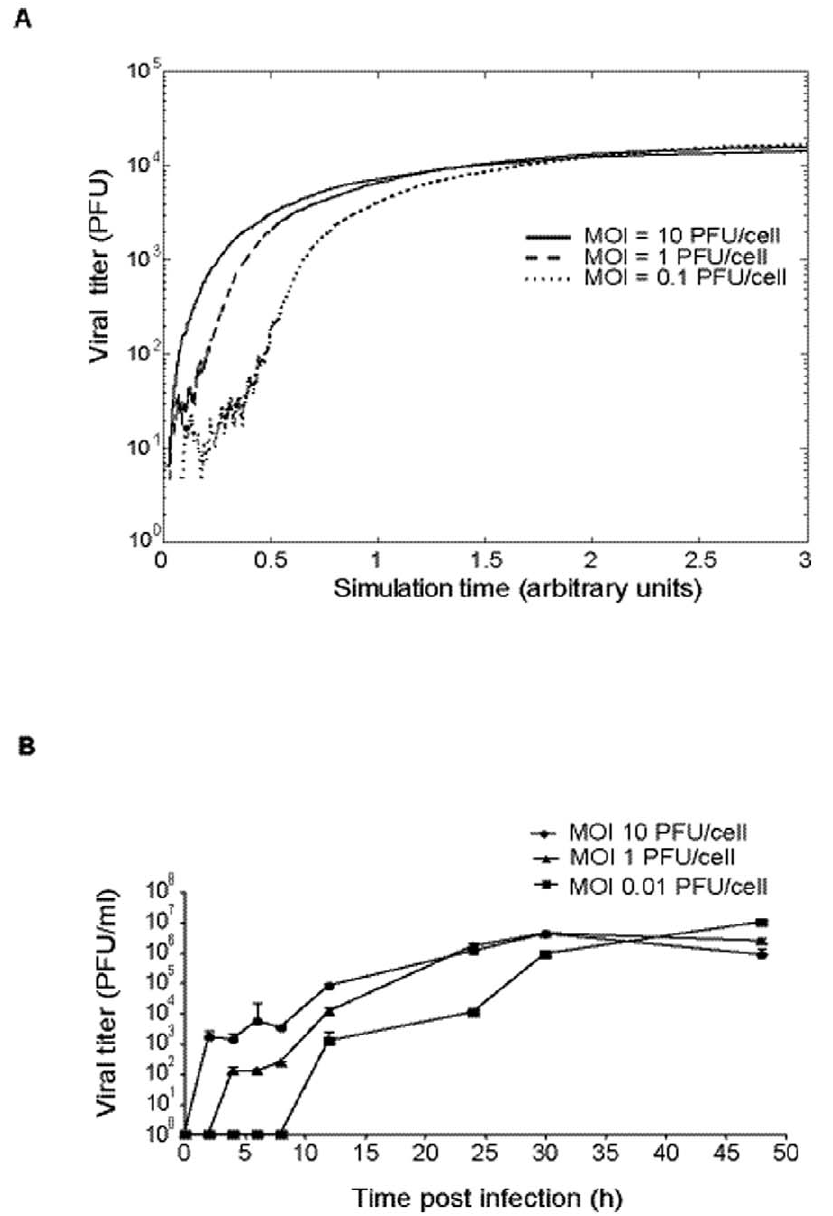
Figure 5. Kinetics of infectious progeny production as a function of the MOI, as predicted the theoretical model, and determined experimentally. A. Computational simulation of infections at MOI of 0.1, 1 and 10 PFU/cell. The parameters used are listed in Text S1 and Table S1. B. Experimental results: BHK-21 cells were infected with LCMV Arm53 at MOIs of 0.01, 1 and 10 PFU/cell, and supernatants were harvested at the indicated times postinfection and titrated. Viral titers are the average of at least four determinations and standard deviations are given. Procedures are described in Materials and Methods.